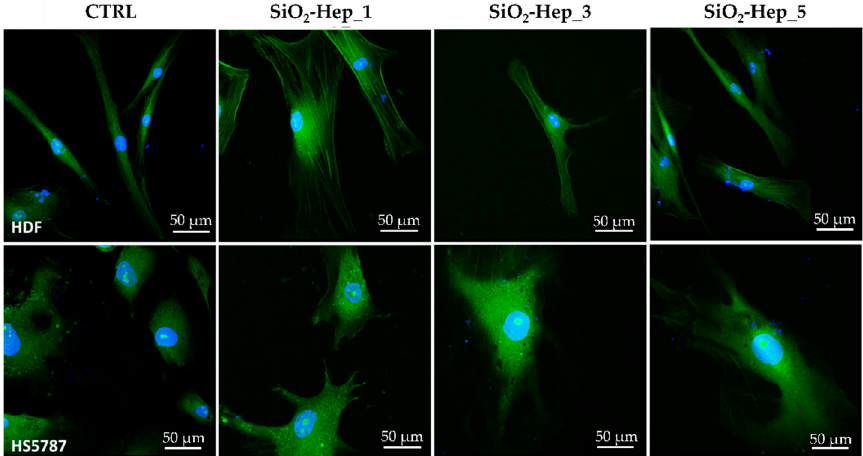
Figure 8. Cell morphology for the control cells and cells incubated with SiO 2 -Hep_1, SiO 2 -Hep_3, SiO 2 -Hep_5 NPs, at concentration of 30 μ g, respectively, after 24 h. In Green Actin filaments stained by phalloidin-FITC and in Blue DAPI stained nuclei cells. All bars represent 50 μ m. In order to evaluate the biocompatibility of SiO 2 -Hep_1, SiO 2 -Hep_3, and SiO 2 -Hep_5